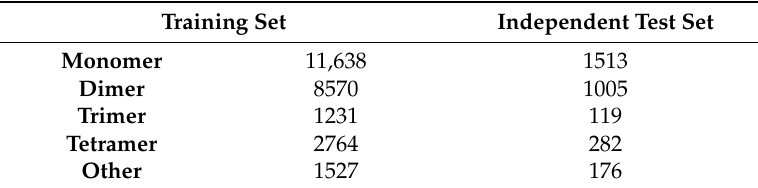
Table 1. Training set and independent test set basis on the year to do classification.